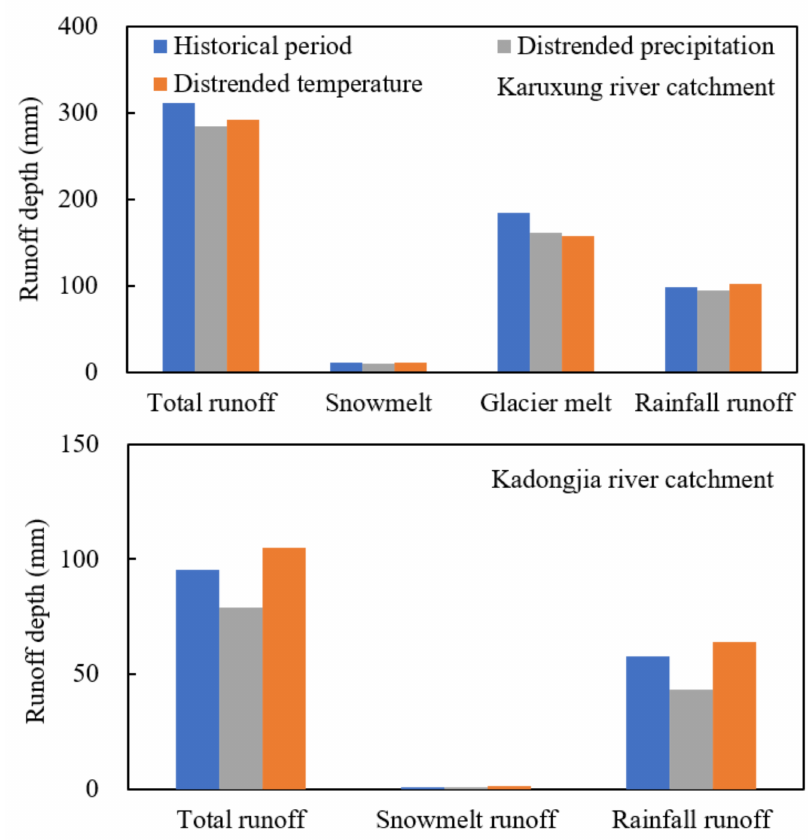
Figure 12. The response of total runoff and its component to climate variables for glacial and non-glacial